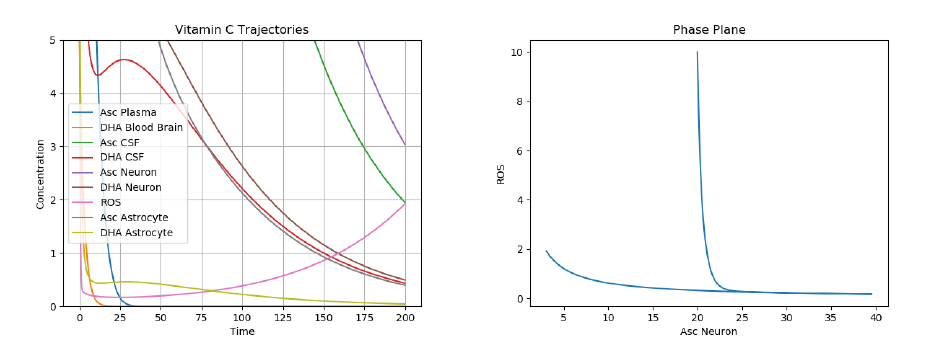
Figure 11. Dynamics of AA, DHA, and ROS in HD with AA